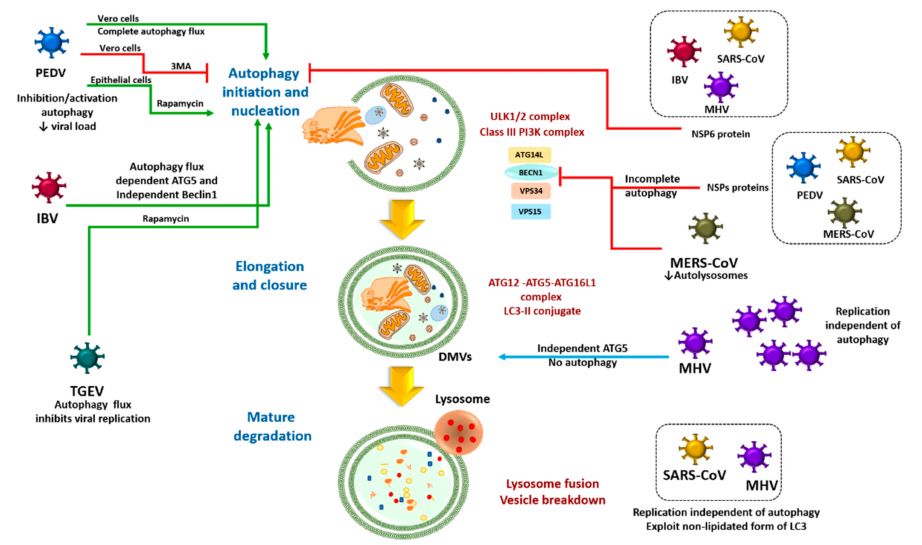
Figure 1. Schematic coronaviruses-autophagy relationship. The figure shows the main findings related to the inhibition or triggering of autophagy by coronaviruses. Green lines represent the complete activation of autophagy by coronaviruses. Red lines show inhibition of autophagy or incomplete autophagy. Blue line indicates the double-membrane vesicles (DMVs) formation by coronaviruses independent of autophagy. In some cellular models, SARS-CoV and mouse hepatitis virus (MHV) exploit the non-lipidated form of LC3 and its replication is independent of